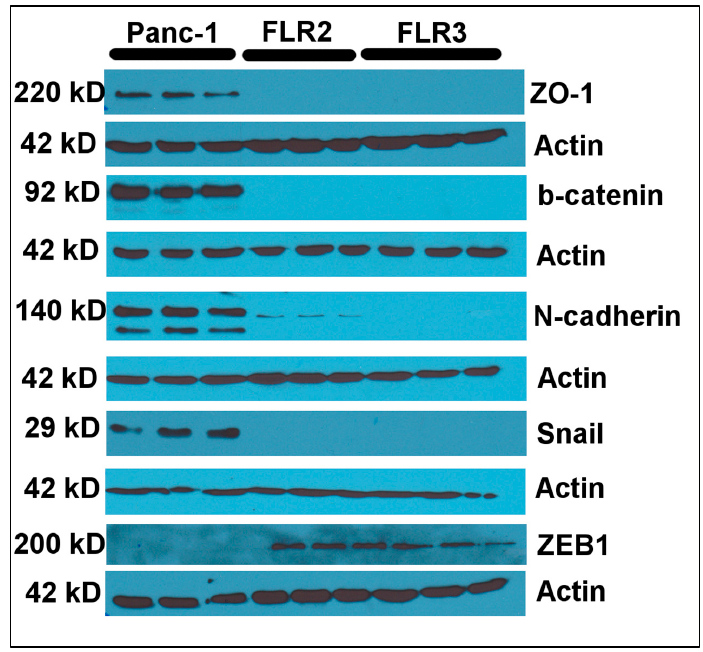
Figure 5. RAGE overexpression results in the reprogramming of several EMT markers. Protein Figure5. RAGEoverexpressionresultsinthereprogrammingofseveralEMTmarkers. Proteinexpression expression levels of five epithelial or mesenchymal markers (ZO ‐ 1, β‐ catenin, N ‐ cadherin, snail, and levels of five epithelial or mesenchymal markers (ZO-1, β -catenin, N-cadherin, snail, and ZEB1) in ZEB1) in three independent cell lysates of WT, FLR2, and FLR3 Panc ‐ 1 cells were determined by three independent cell lysates of WT, FLR2, and FLR3 Panc-1 cells were determined by Western blot. Western blot. Actin was used as a loading control. Actin was used as a loading